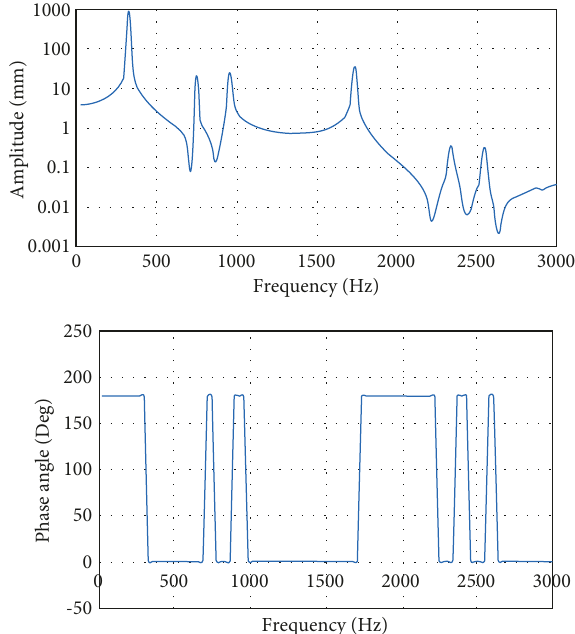
Figure 10: Frequency response diagram of stainless-steel crankshaft.